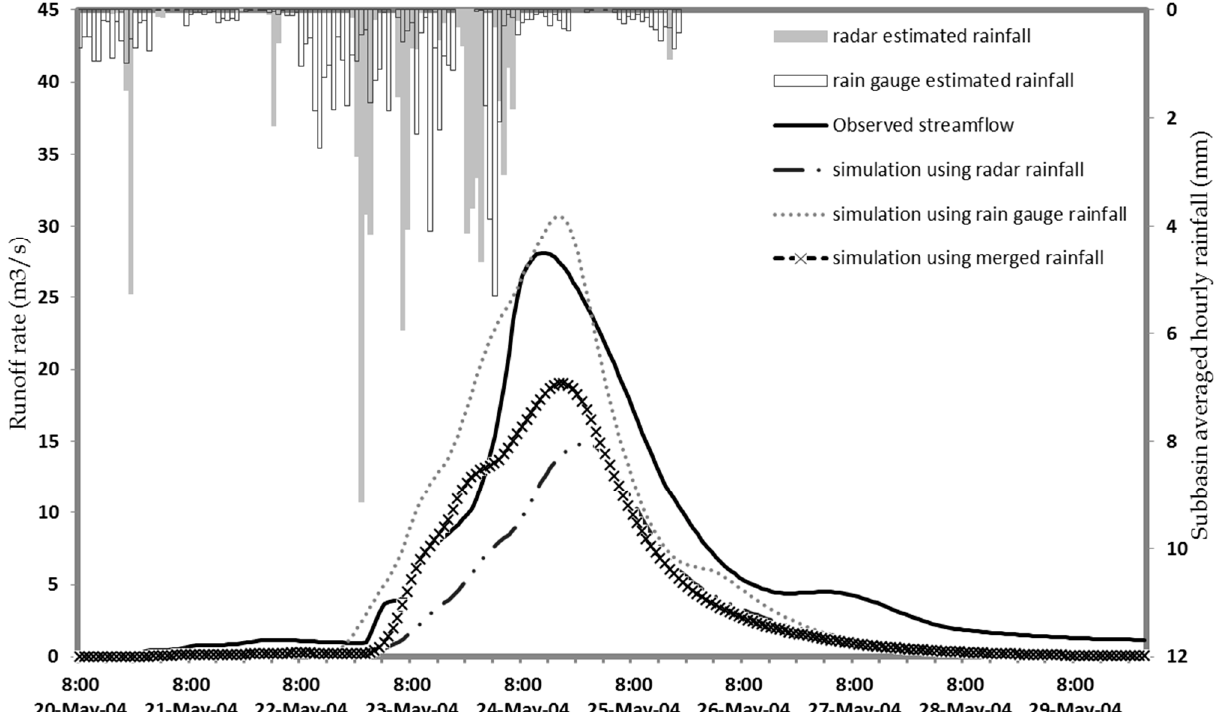
Figure 26. Comparison of estimated and observed hydrographs using different rainfall estimates for the 20 May 2004 event with Green and Ampt modeling option.